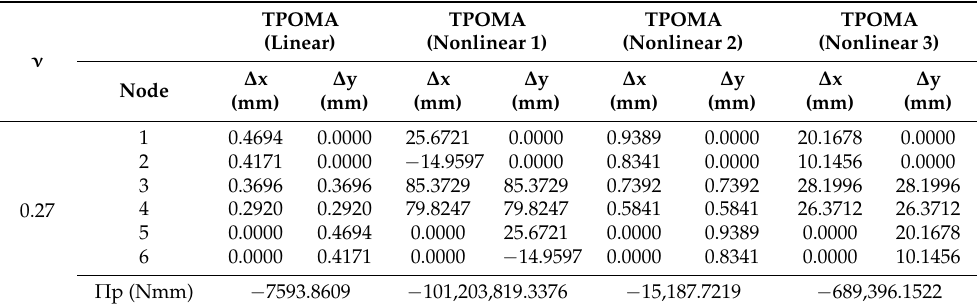
TPOMA TPOMA TPOMA TPOMA (Linear) (Nonlinear 1) (Nonlinear 2) (Nonlinear